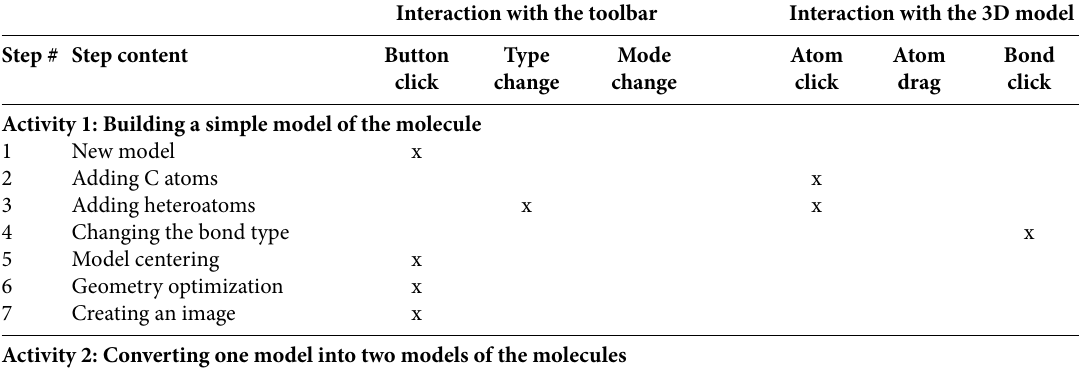
Table 2: Steps for each activity with the required interaction with the toolbar and the 3D model Interaction with the toolbar Interaction with the 3D model